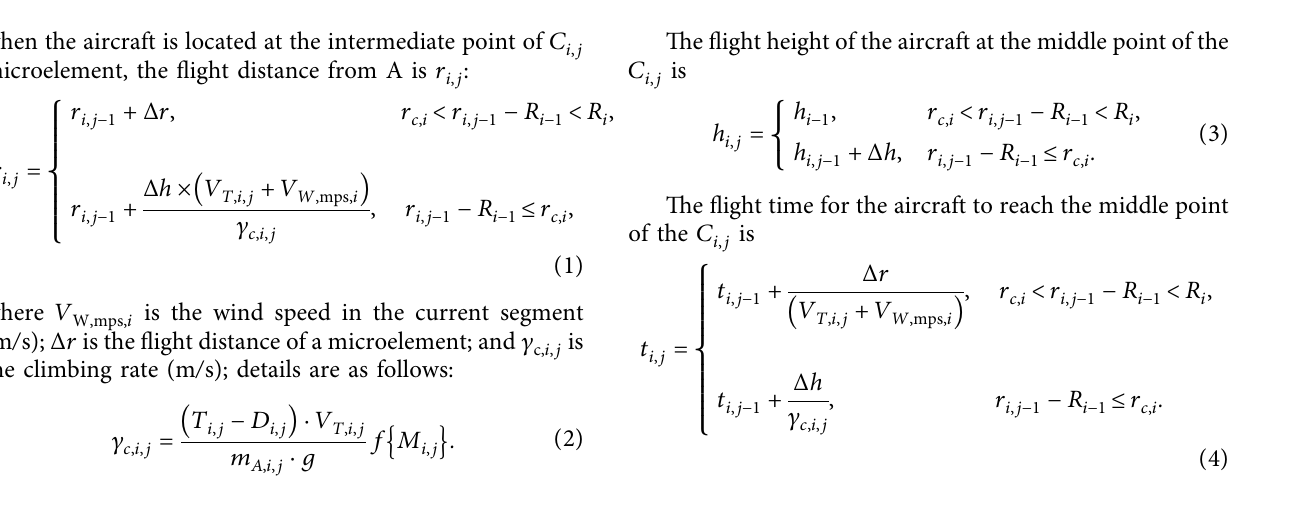
Figure 2: Aircraft multiple waypoint collaborative constraint departure mode. (a) Vertical trajectory pattern. (b) Horizontal trajectory